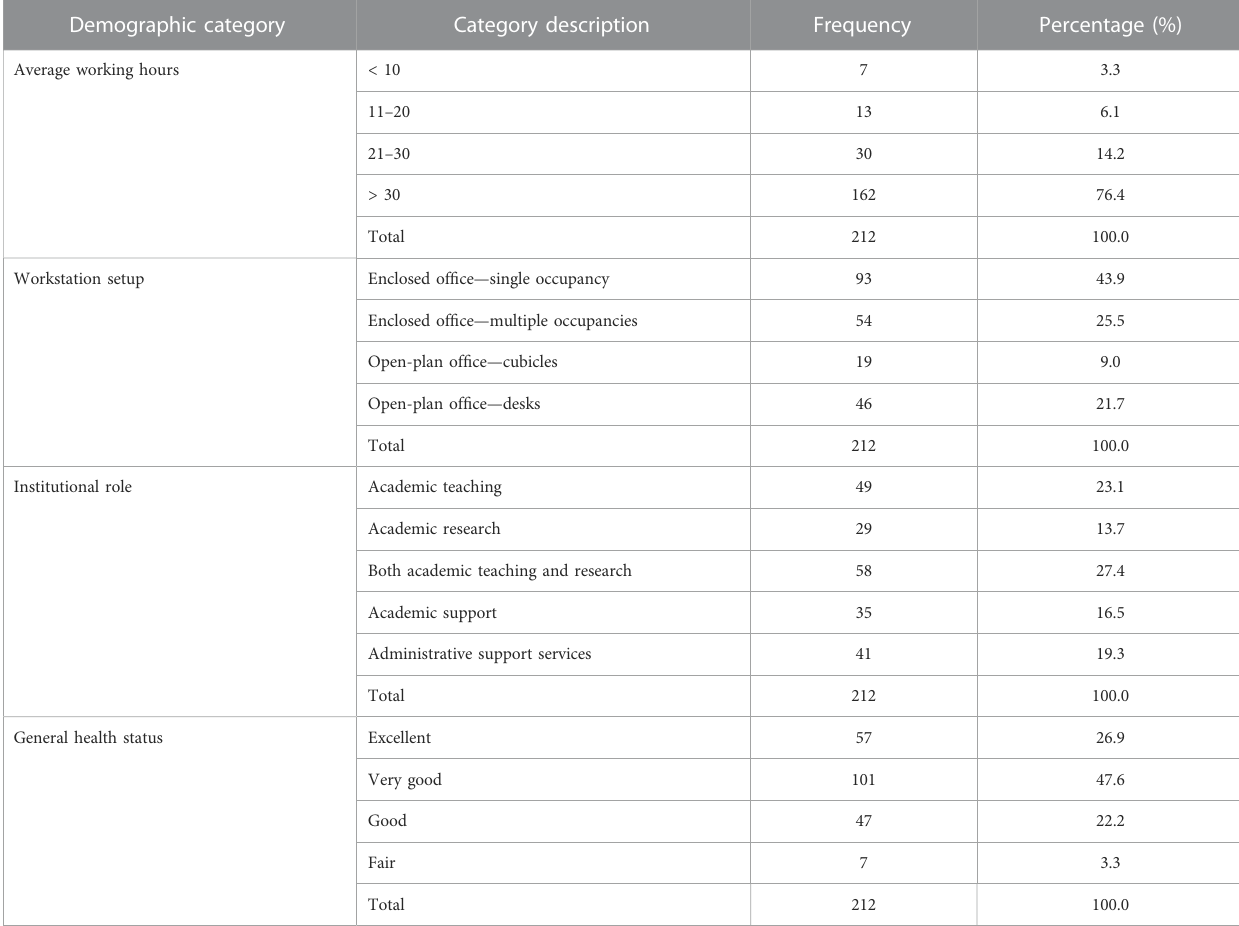
TABLE 2 Background information of the